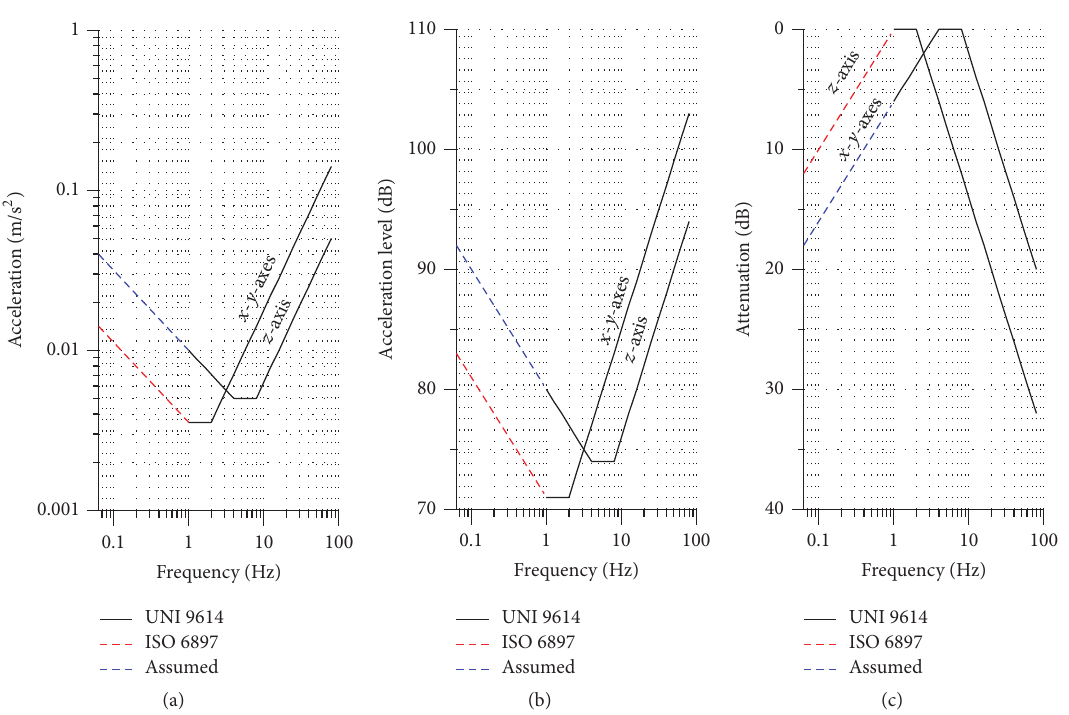
Figure 3: Perception of building motion by humans: adopted acceleration threshold curves (a); corresponding acceleration level curves (b); attenuation curves